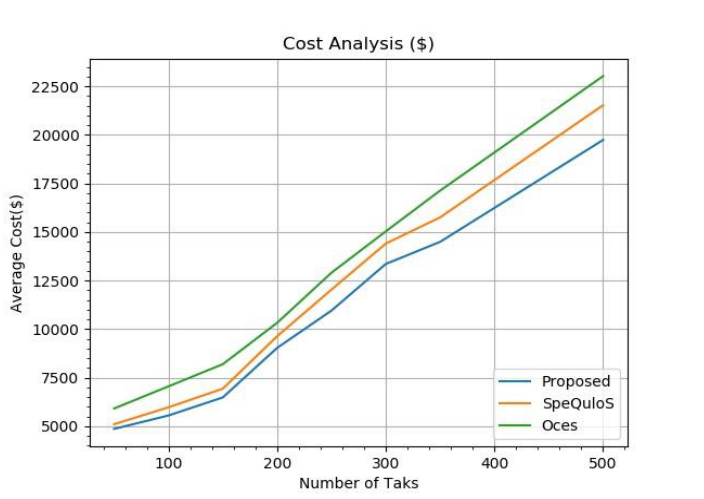
Figure 3. Cost Analysis of proposed work (ms)